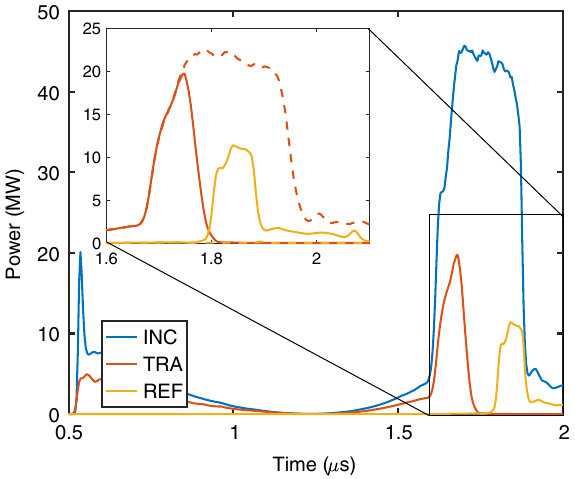
FIG. 5. rf power signals in the case of a breakdown without beam. Incident (INC), transmitted (TRA) and reflected (REF) power signals are reported. The previous pulse TRA and REF signals (with no breakdown) are reported dashed in the inset.